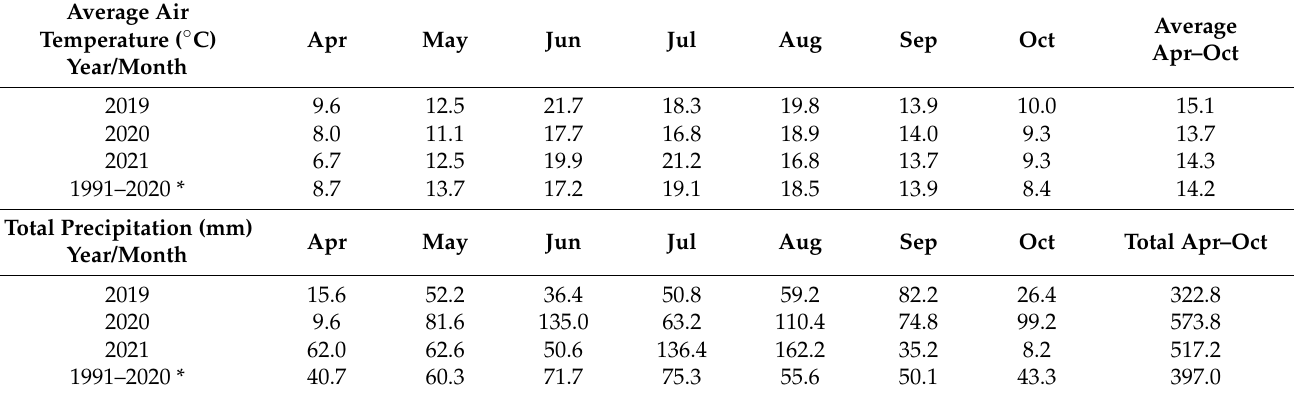
Table 1. Average air temperature and total precipitation in D ˛abrowice in the 2019–2021 growing